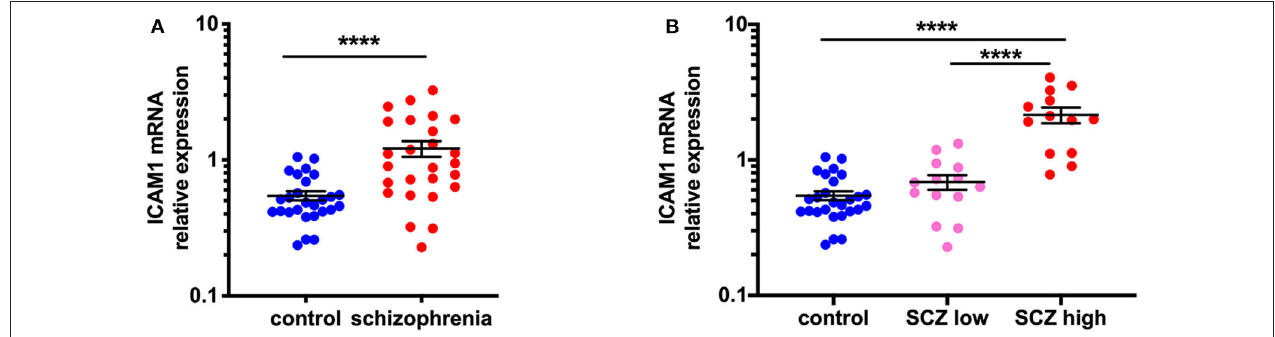
FIGURE 1 | ICAM1 gene expression is increased in the midbrain in schizophrenia cases with a high inflammatory biotype. (A) Gene expression of ICAM1 was increased in the midbrain of schizophrenia cases compared to controls ( t = − 5.25, df = 40.40, p < 0.0001). (B) Analysis by inflammatory subgroup revealed this increase was in the subgroup of schizophrenia cases with a high inflammatory biotype ( F = 39.84, df = 51,2, p < 0.0001). Data are mean ± SEM, **** p < 0.0001. SCZ low, low inflammatory/schizophrenia; SCZ high, high